Question: How would you classify this visualization?
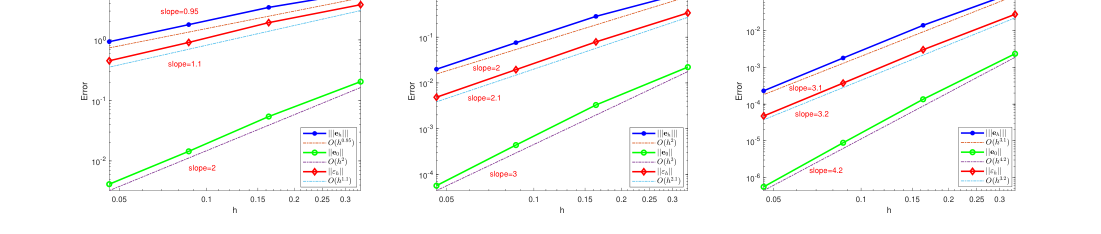
Answer: line